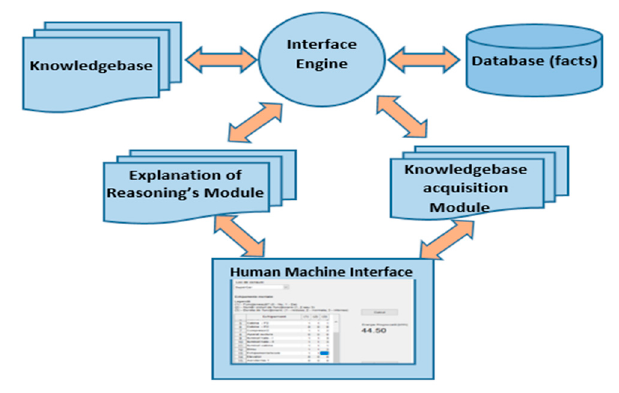
Figure 8. The framework of the expert system.